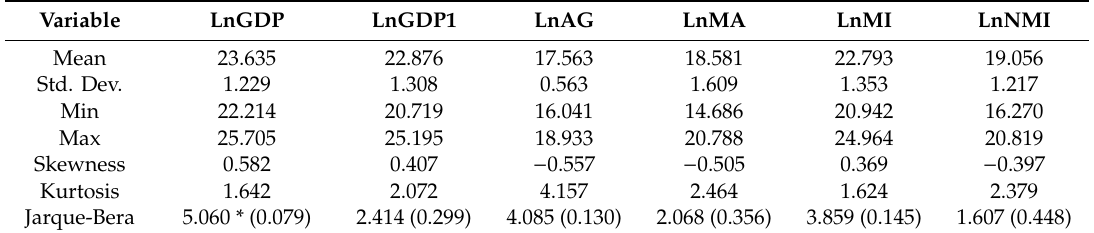
Table 2. Descriptive statistics and correlation of variables (in natural